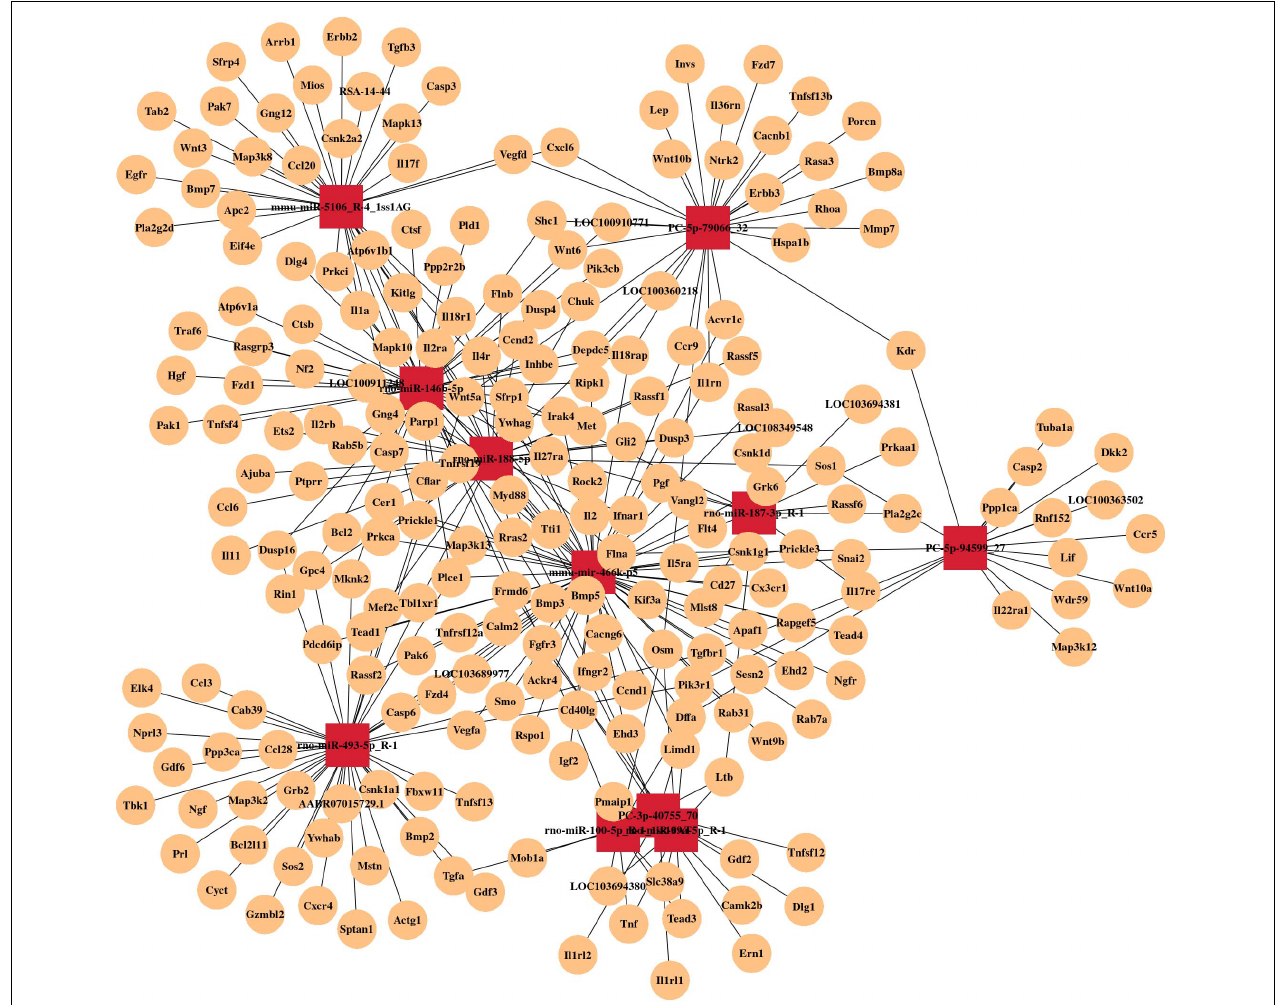
FIGURE 6 | MicroRNA mRNA network. The relationship between differentially expressed miRNAs and their target